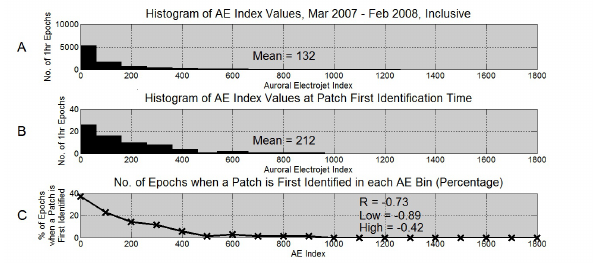
Fig. 9. (a) Histogram of hourly AE index values for the study pe- riod. (b) Histogram of AE values at times when TRACK first iden- tifies a patch. (c) AE values at times when TRACK first identifies a patch vs. percentage of identified patches when that AE value pre- vailed. A quite good anti-correlation exists between AE and times when TRACK first identifies a patch.